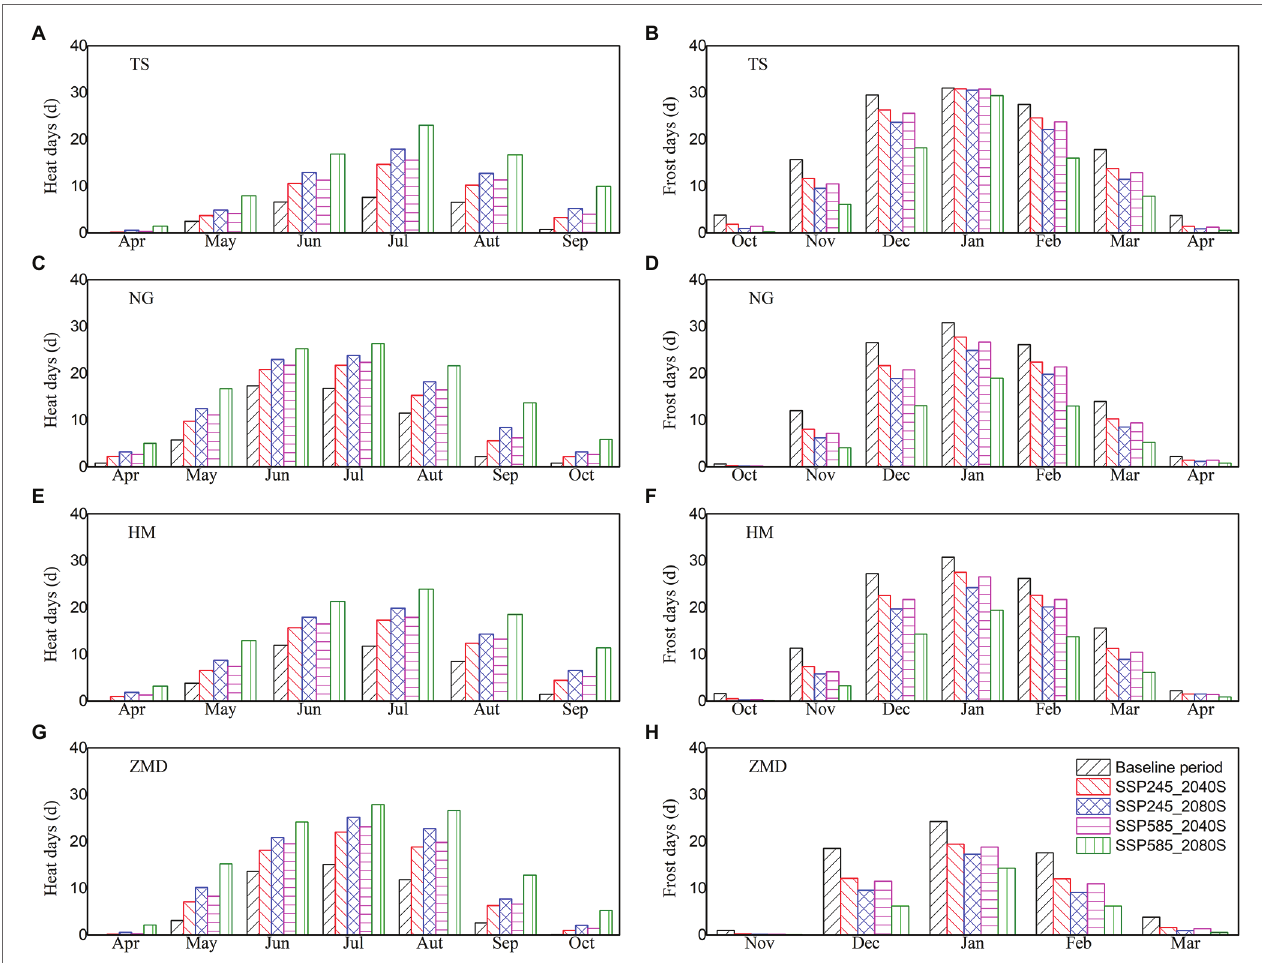
FIGURE 2 | Monthly heat (A,C,E,G) and frost (B,D,F,H) days for baseline period and two future periods under SSP245 and SSP585